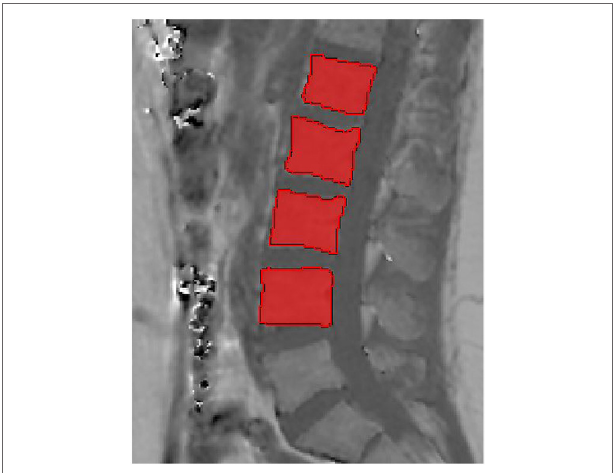
FigUre 1 | Representative segmentation of the vertebral bodies of L1–L4 in the proton density fat fraction map of a 29-year-old male.